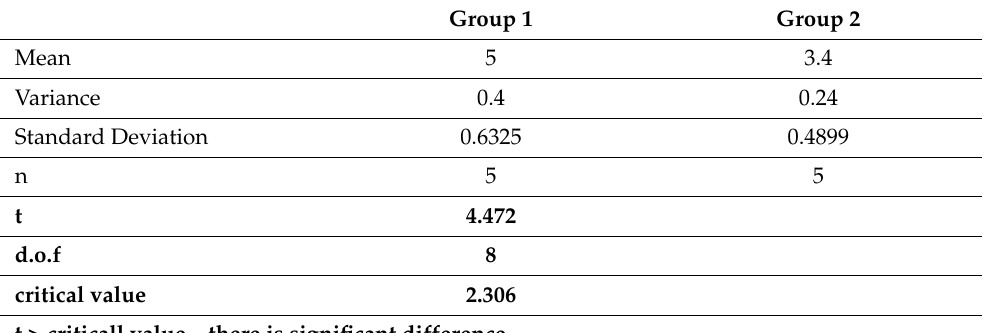
Table 5. Results of the data analysis, group 2 represent data when using the